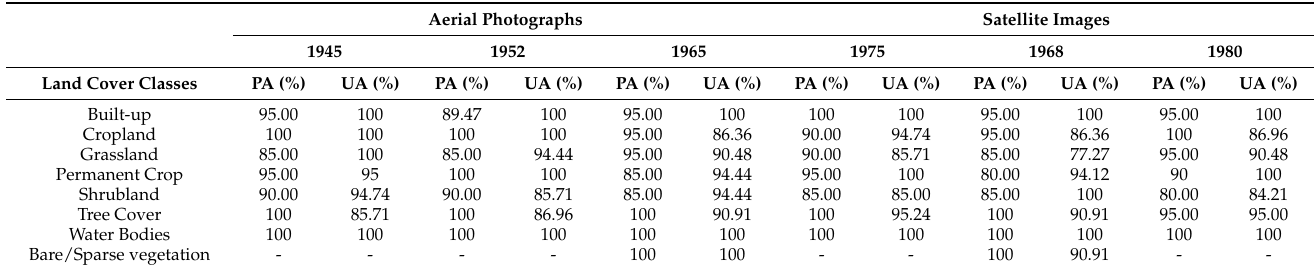
Table 7. Producer’s and user’s classification accuracies for the Ruen region.